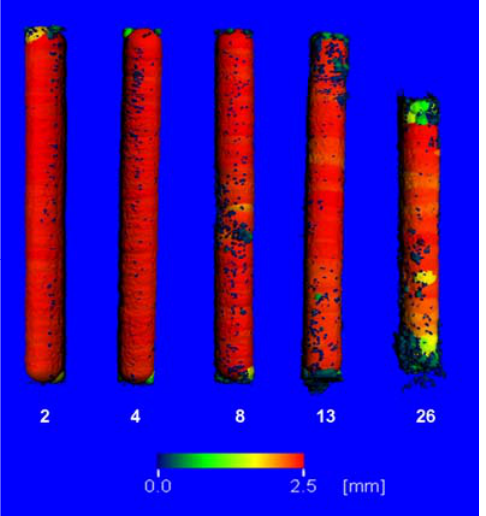
Figure 3. Images of the LANd442 implants’ true 3D-thicknesses following different implantation durations in the rabbits’ tibiae: from left to right: after 2 weeks, 4 weeks, 8 weeks, 13 weeks and after 26 weeks implantation periods. The colors correspond to the maximum diameters of the inserted balls; from red, yellow, green to blue, the diameter becomes smaller (red = 2.5 mm; blue = almost